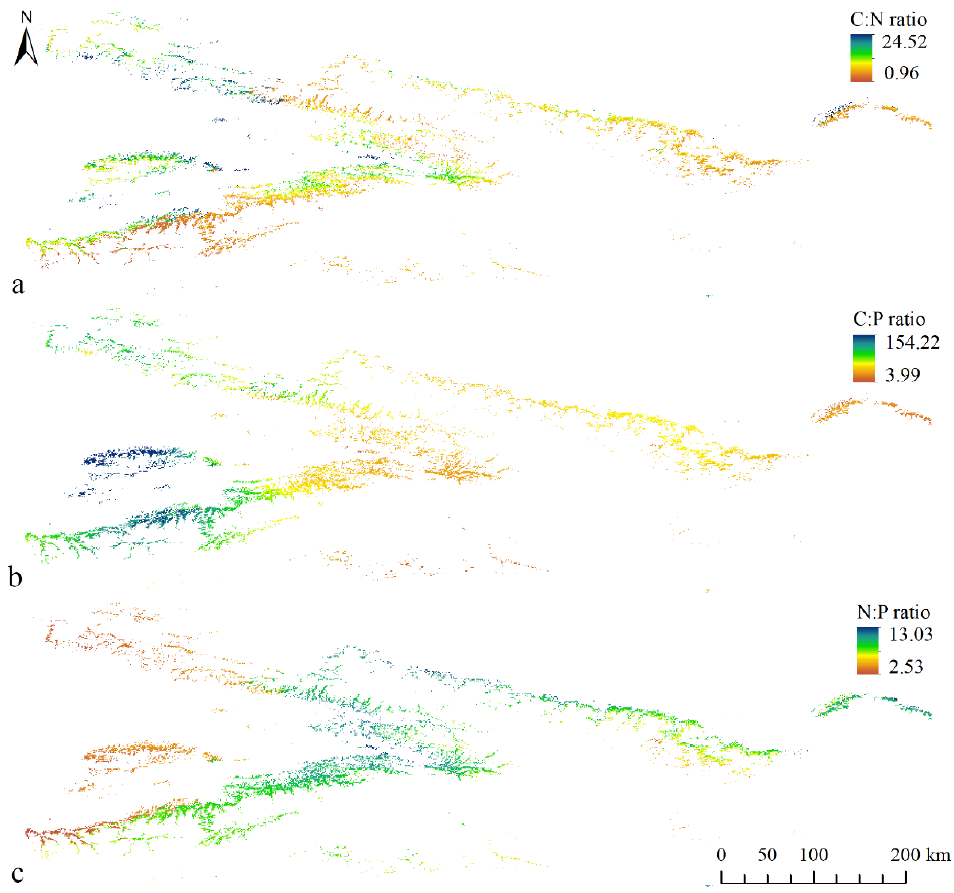
Figure 3. Modeled spatial distribution of soil C:N ( a ), C:P ( b ) and N:P ( c ) in the P. schrenkiana